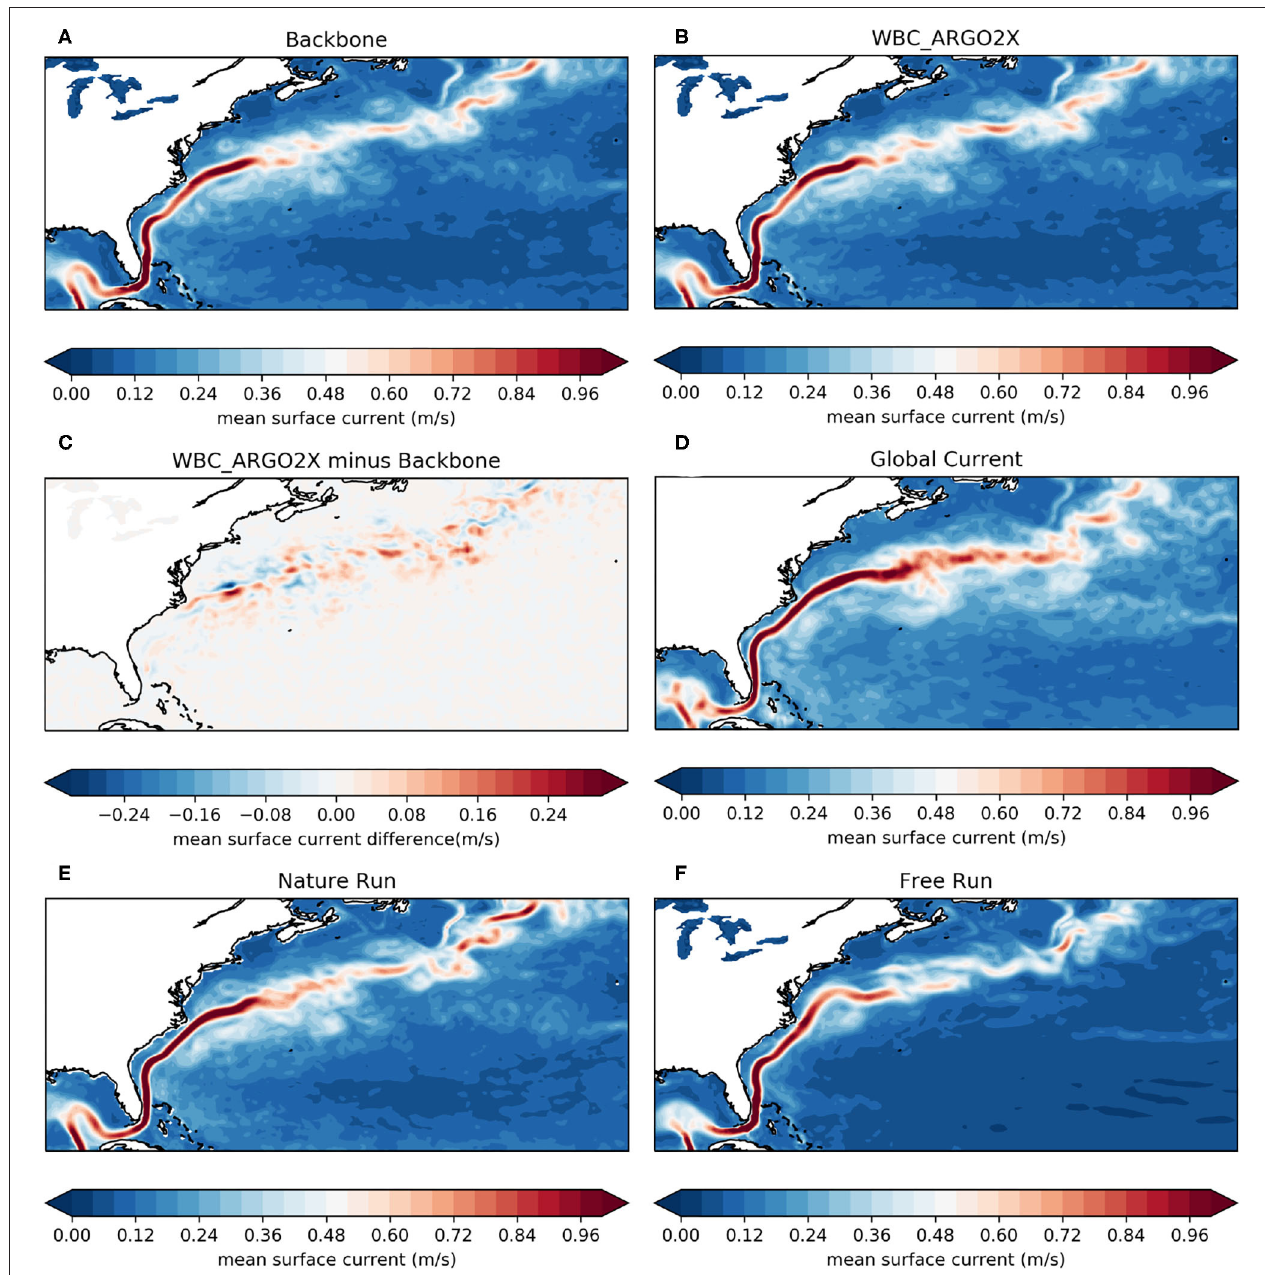
FIGURE 8 | Annual mean surface current speed over 2009 for: (A) the Backbone, (B) the WBC_ARGO2X, (C) the WBC_ARGO2X minus the Backbone differences, (D) the observation-derived GlobCurrent v3.0 surface currents product (Rio et al., 2014) (E) the Nature Run, and (F) the Free Run.